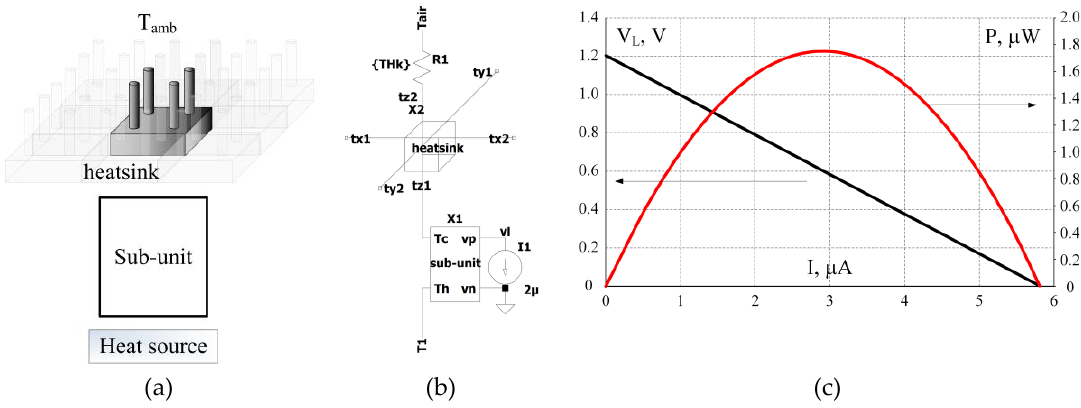
Figure 14. Fragment of the on-chip harvester including single sub-unit, heat source and fragment of a heatsink. ( a ) Block-diagram of the system, ( b ) equivalent circuit representation ar LTSpice. T 1 = 35 ◦ C is a heat source temperature, X1 is a hierarchical block of the circuit shown in Figure 13, X2 is a block of the heatsink base and the R1 is the thermal resistance of a part of the heatsink, ( c ) V-I and P-I of the circuit.